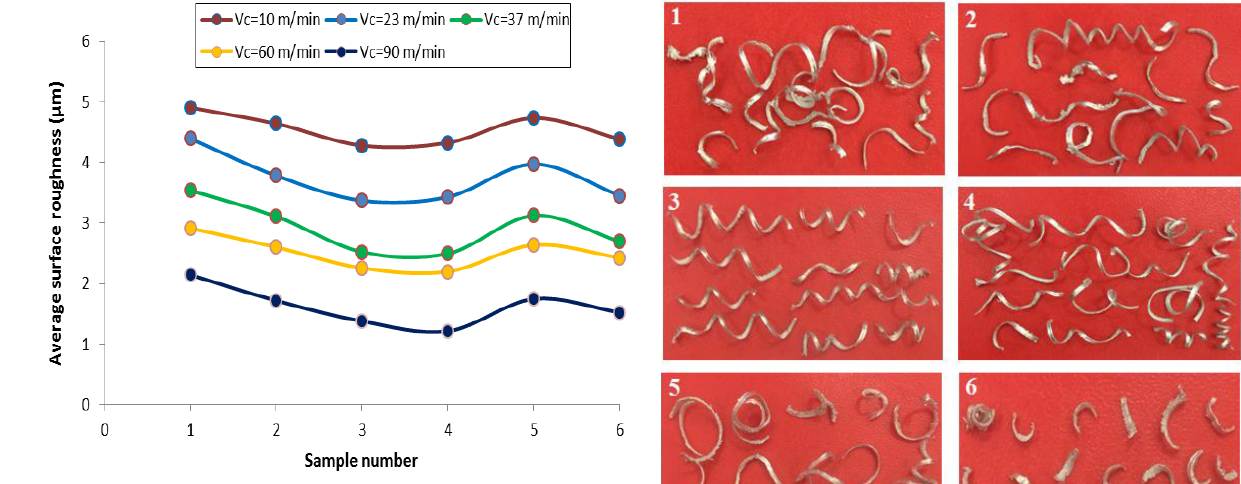
Figure 5: Effect of cutting speed on average surface roughness within different sample detail compositions.